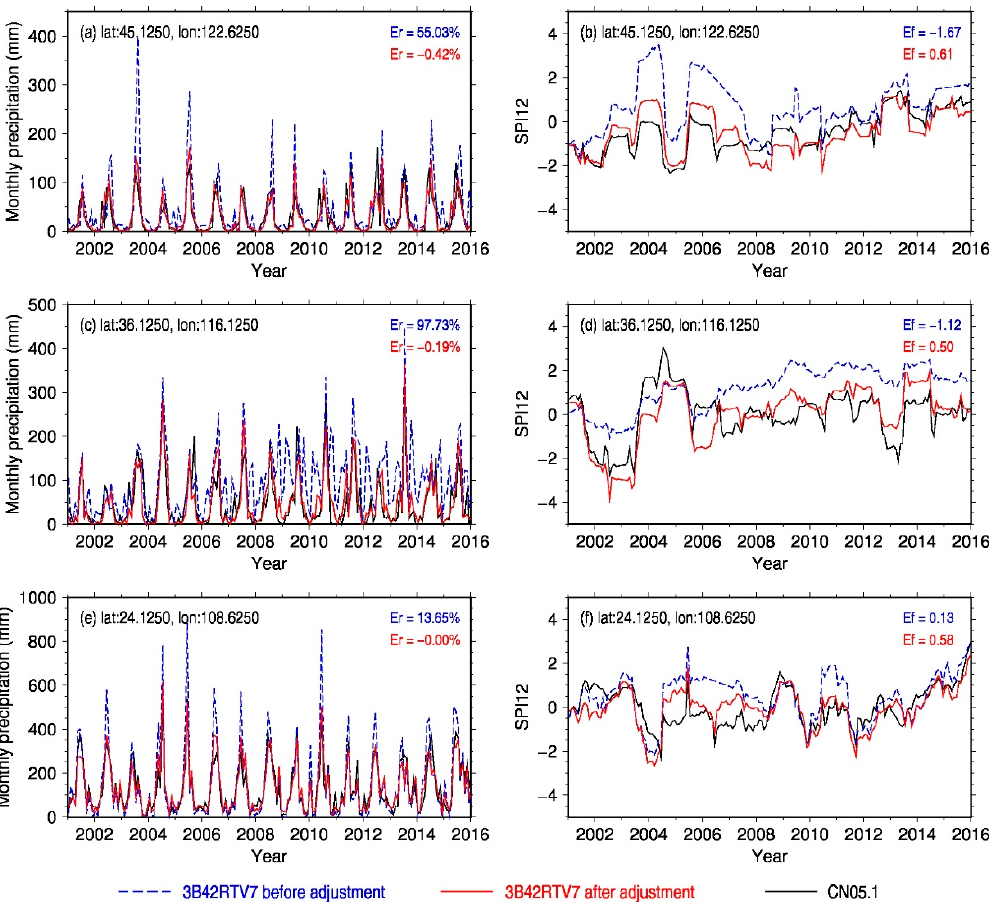
Figure 4. Comparisons of monthly precipitation and the 12-month SPI (SPI12) from the UN-SGMP (blue dash line), SGMP (red line), and OBS data (black line) during the overlapping period (2001–2016) in three example grid cells.